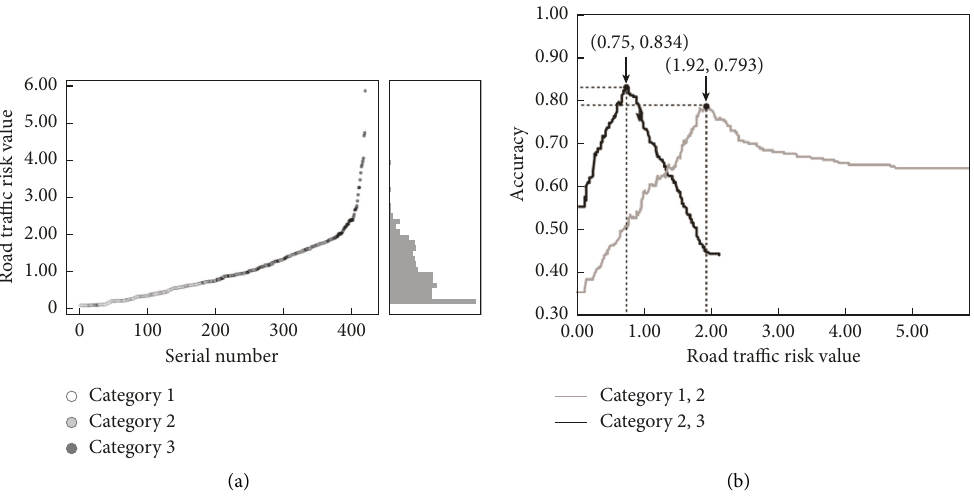
Figure 7: Determination of the classification threshold. (a) Road traffic risk value ranking. (b) Classification thresholds.